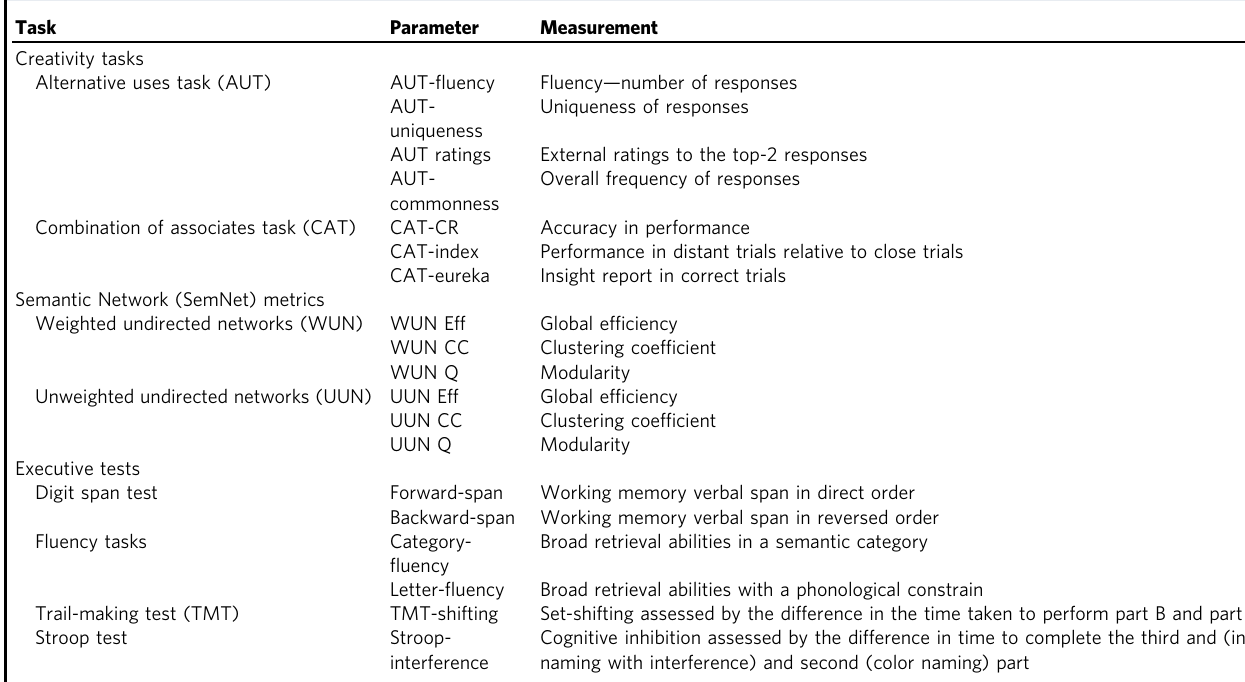
Table 2 Behavioral